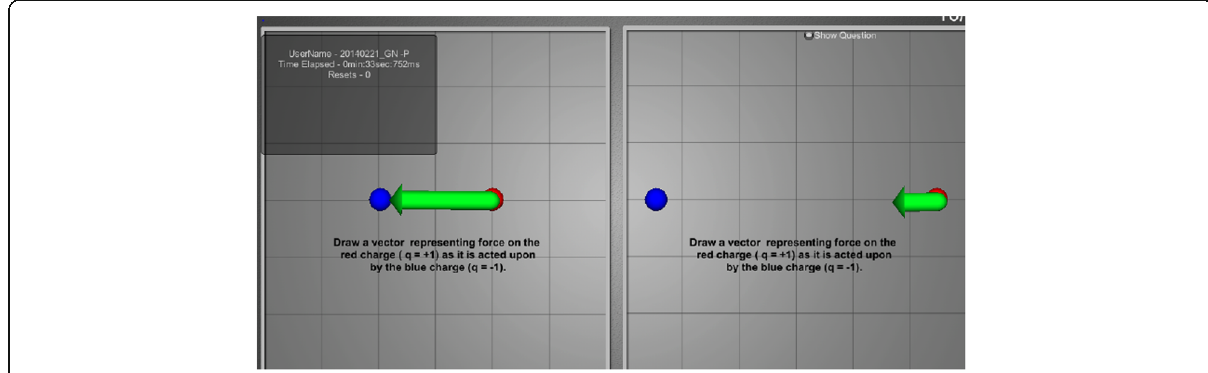
Fig. 8 Expert answer to questions 7 and 8 which appeared on same screen. Most important is that vector in the final question (right-hand panel) is shorter than the vector in the left-hand